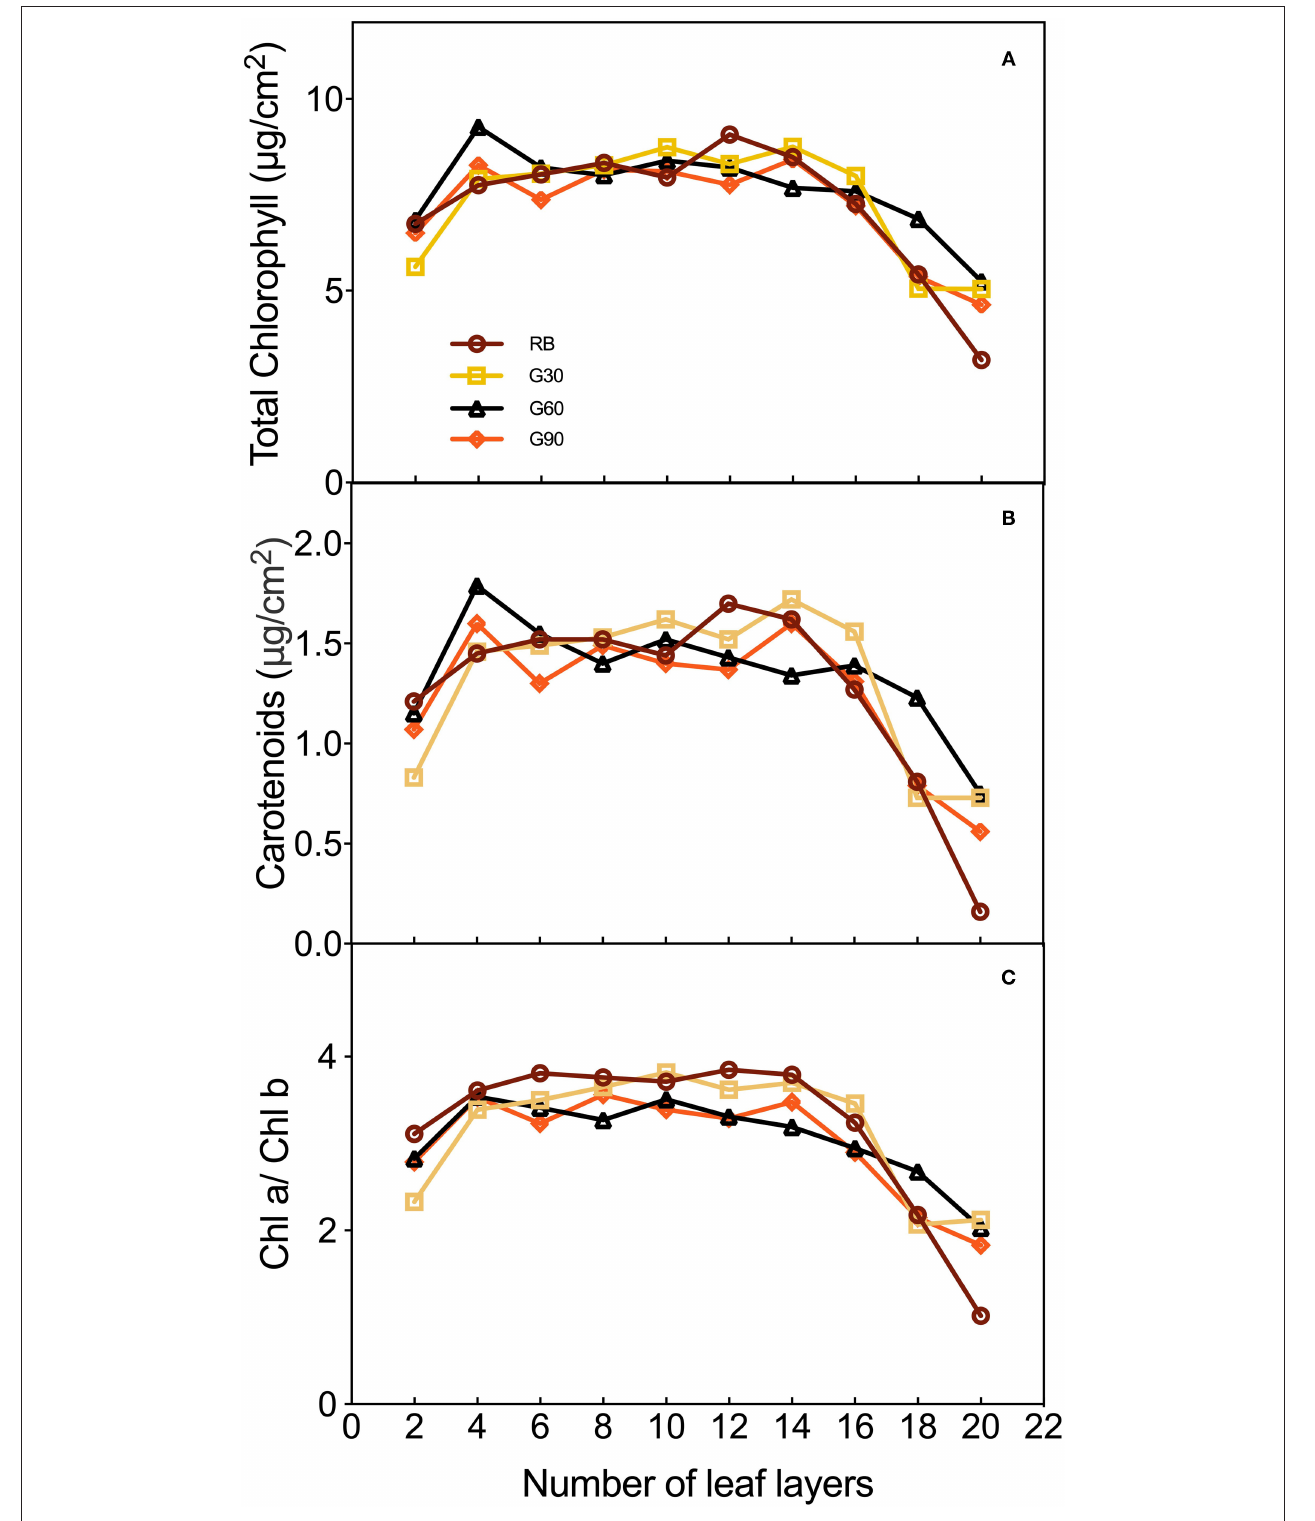
FIGURE 6 | The concentrations of total chlorophyll (A) , carotenoids (B) , and of leaves and Chl a/Chl b (C) of different layers of lettuce plants as affected by the different proportions of green light.